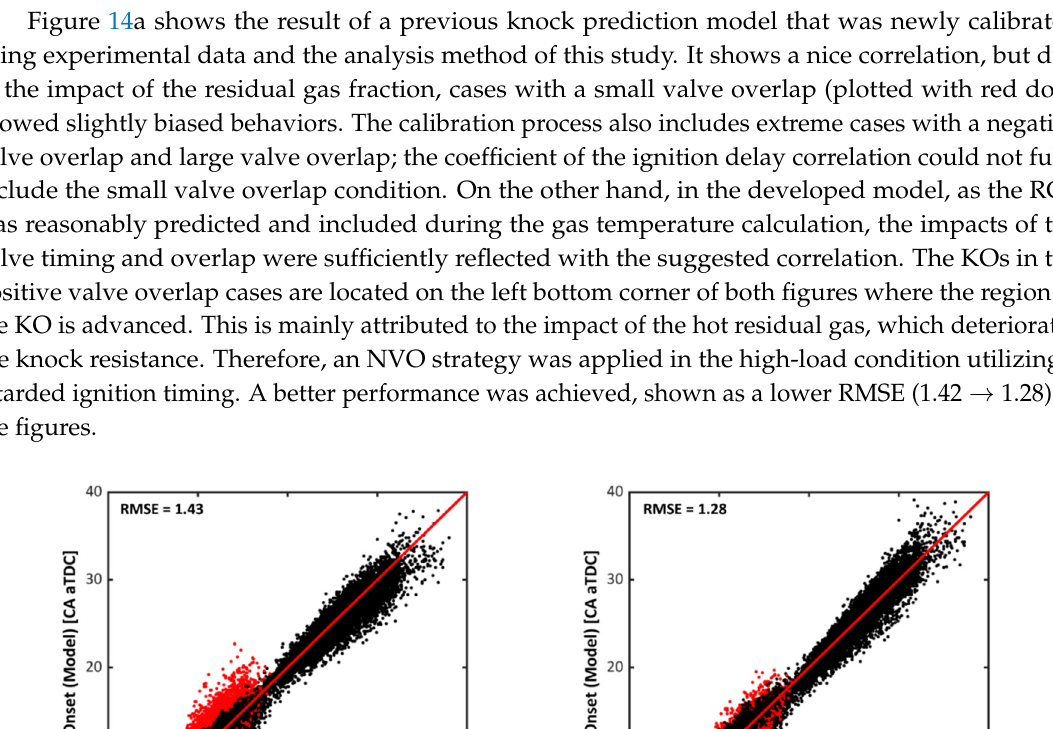
Figure 13. Results of knock prediction modeling: ( a ) methodology not applied; ( b ) methodology applied.